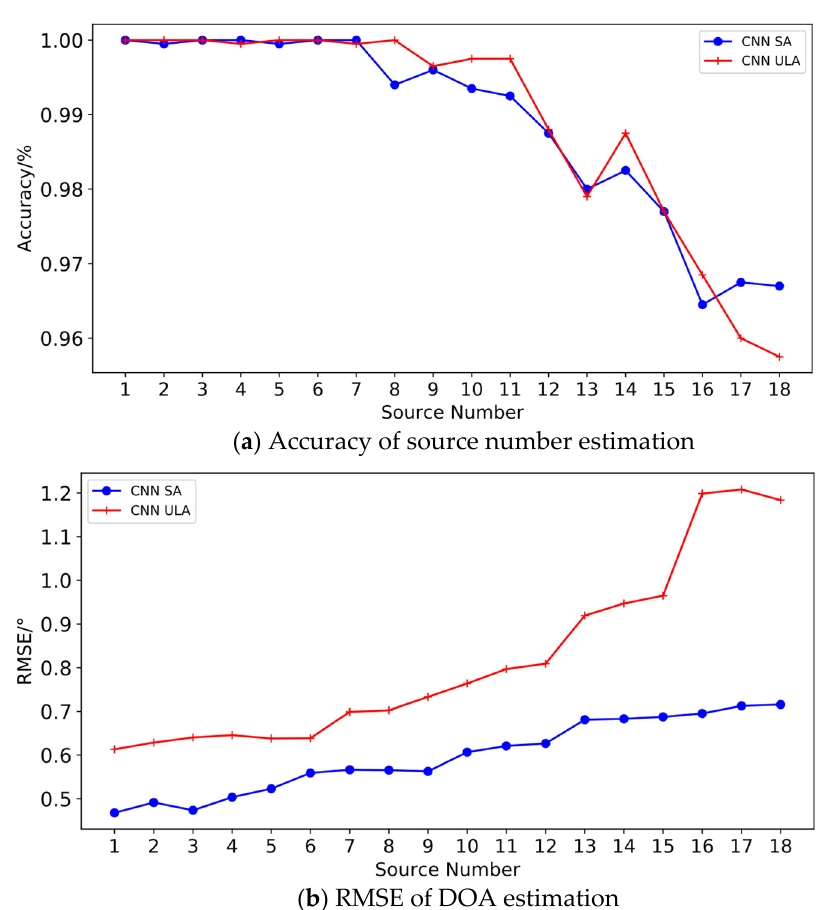
Figure 6. Performance of CNN algorithms for source number and DOA estimation at low snapshot and low SNR.